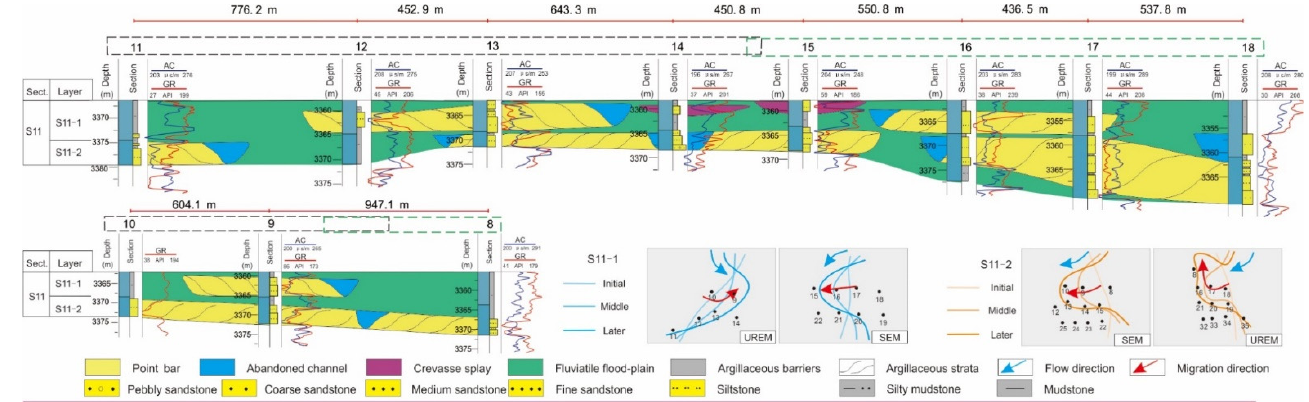
Figure 16. Profile T2 and T3 of comprehensive analysis including evolution model of meander bend-based multiple connected core wells which are collected from database in S 11 sublayer of Su-X block, Sulige gas field, Ordos Basin, China: migration areas Z1 (green frame), Z2 (black frame).